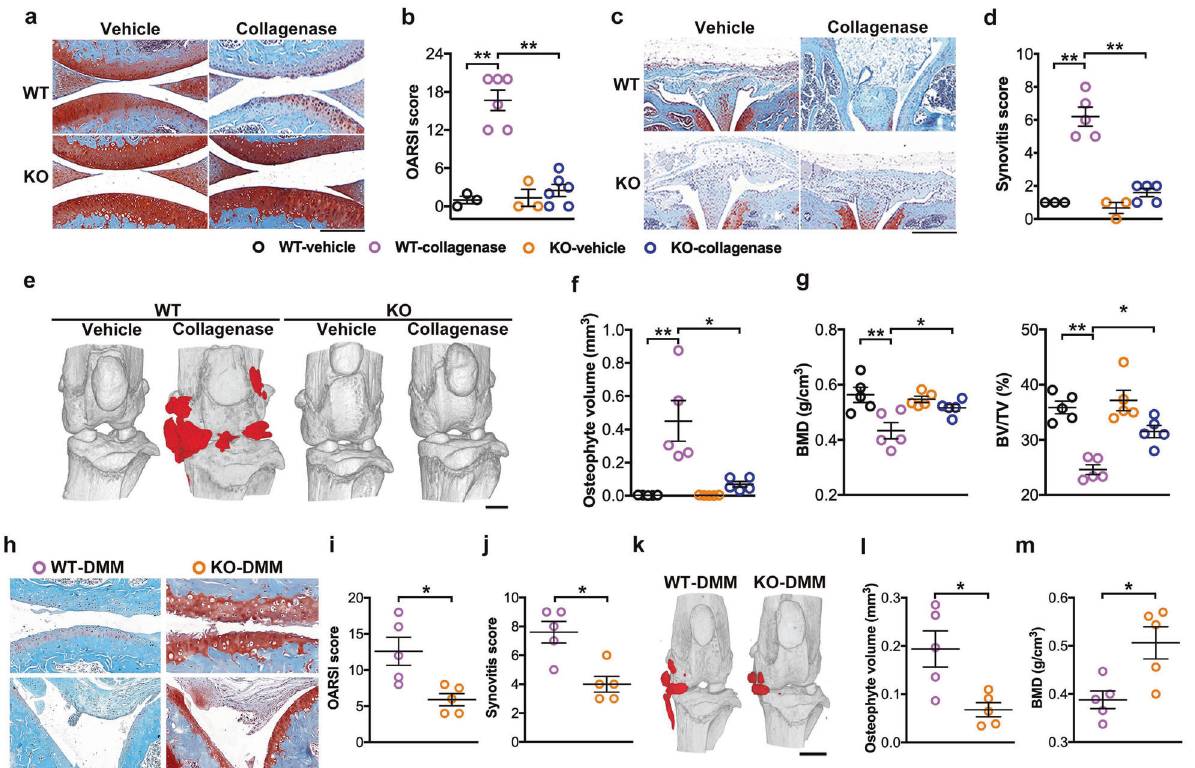
Fig. 4 UtxKO mice showed few signs of collagenase or destabilized medial meniscus-induced gonarthrosis. Upon OA induction, UtxKO mice developed weaker symptoms, including articular cartilage degradation ( a ; scale bar, 20 μ m) and quantitative OARSI scores ( b ) together with synovitis ( c ; scale bar, 100 μ m) and synovitis scores ( d ). Utx loss compromised osteophyte formation ( e scale bar, 500 μ m), osteophyte volume (f ) and loss in subchondral BMD and BV/TV ( g ) of UtxKO mice. Eight weeks DMM postoperatively, UtxKO mice showed less cartilage damage and synovitis ( h scale bar, 20 μ m) together with decreased OARSI scores ( i ) and synovitis scores ( j ) than WT mice. Osteophyte formation ( k ), osteophyte volume ( l ), and subchondral bone BMD ( m ) were compromised in UtxKO mice. Data are expressed as mean ± standard errors calculated from fi ve to six mice. * P < 0.05; ** P <